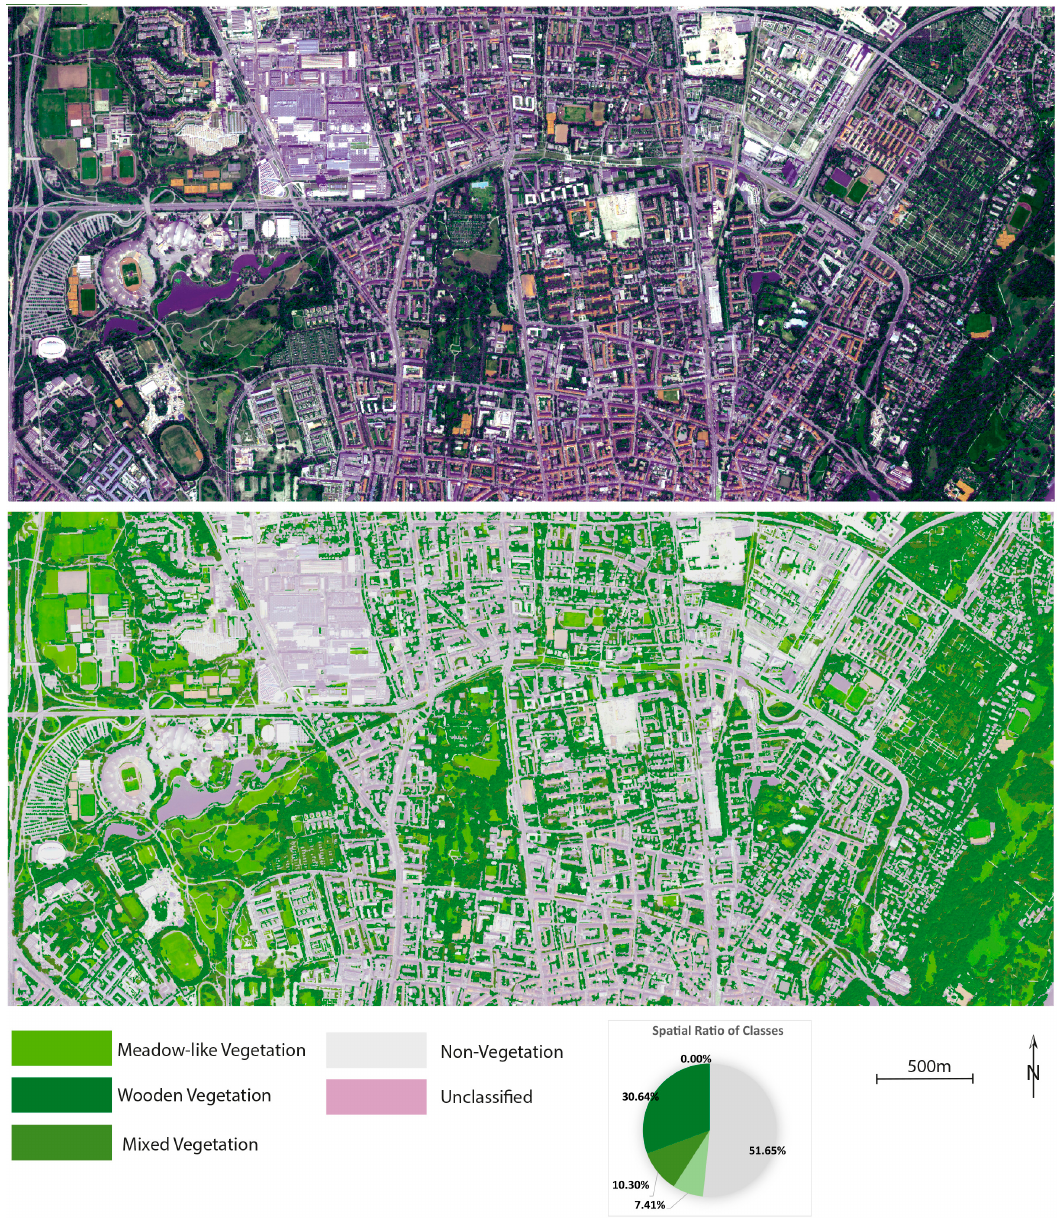
Figure 3. Top: Original image, standard deviation stretched (3.0%) R = WV-2 band 5; G = (WV-2 band 3 + WV-2 band 6)/2; B = WV-2 band 2. Bottom: Initial classification result for L -classes ( µ 0 > 0.0) superimposed over top image with 33% transparency.